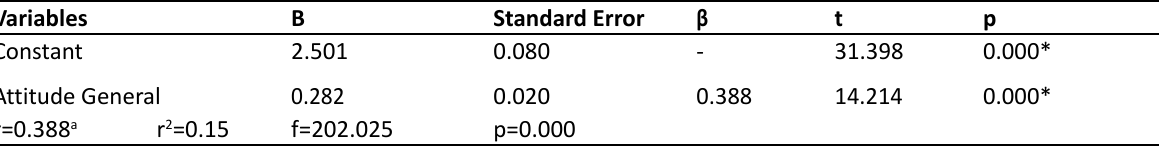
Table 3. Simple regression analysis results of attitude towards physical education course Variables Constant